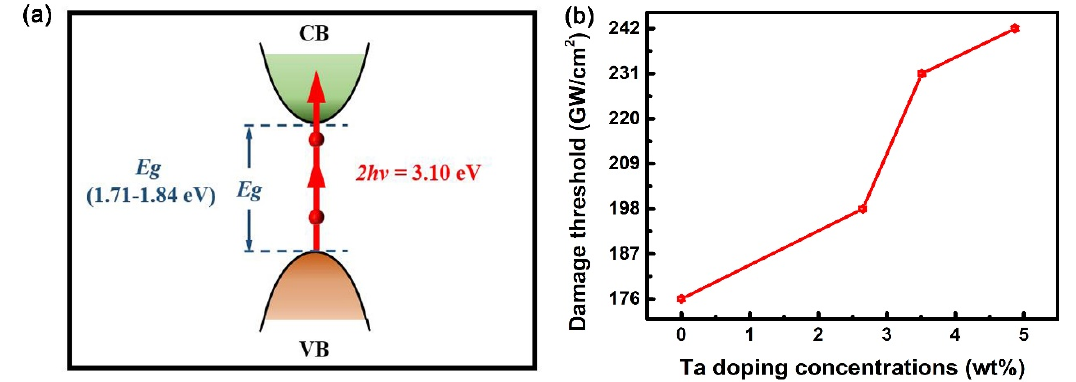
Figure 9. ( a ) The two-photon absorption (TPA) process and ( b ) damage threshold of Ta-doped InTe thin films.